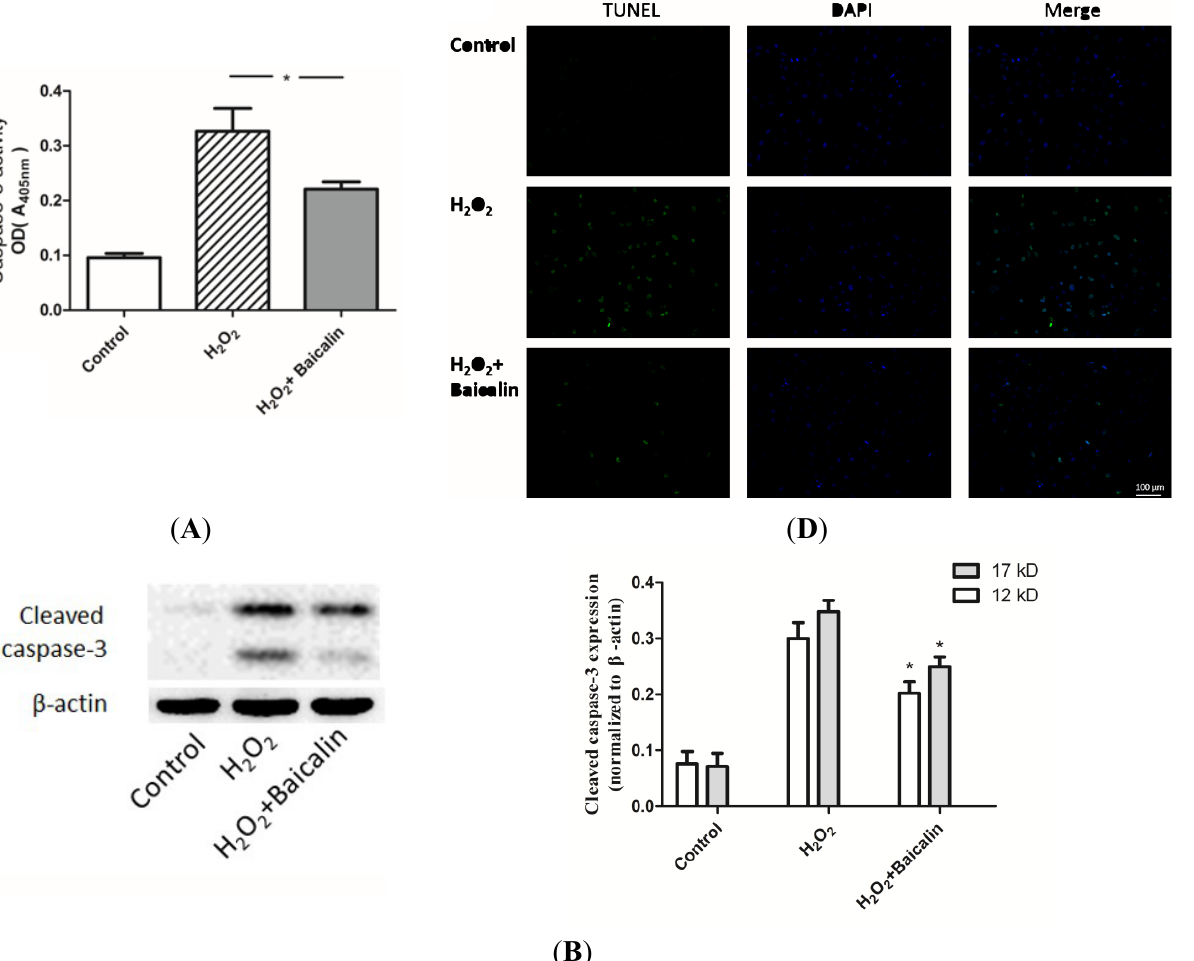
O -induced apoptosis in HK-2 cells. The activity 2 2